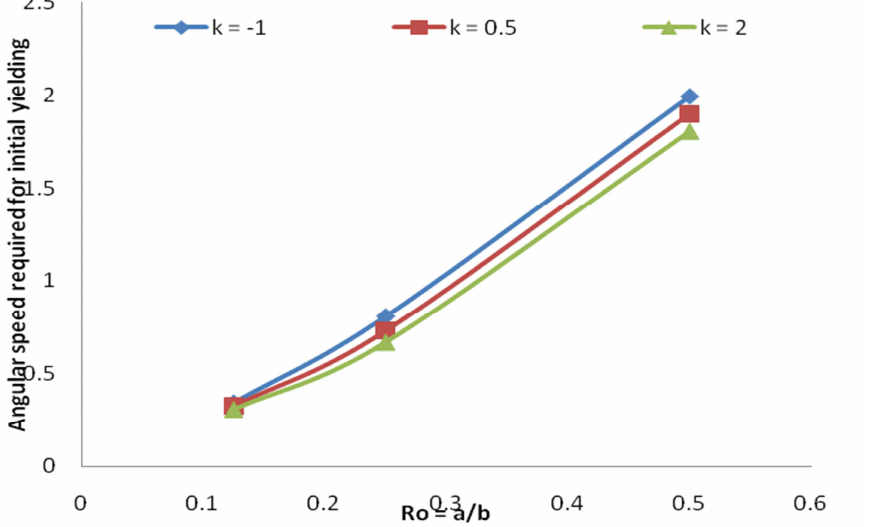
Figure 2 . Angular speed required for initial yielding at the internal surface of the rotating disc with rigid inclusion along the radii ratio baR /